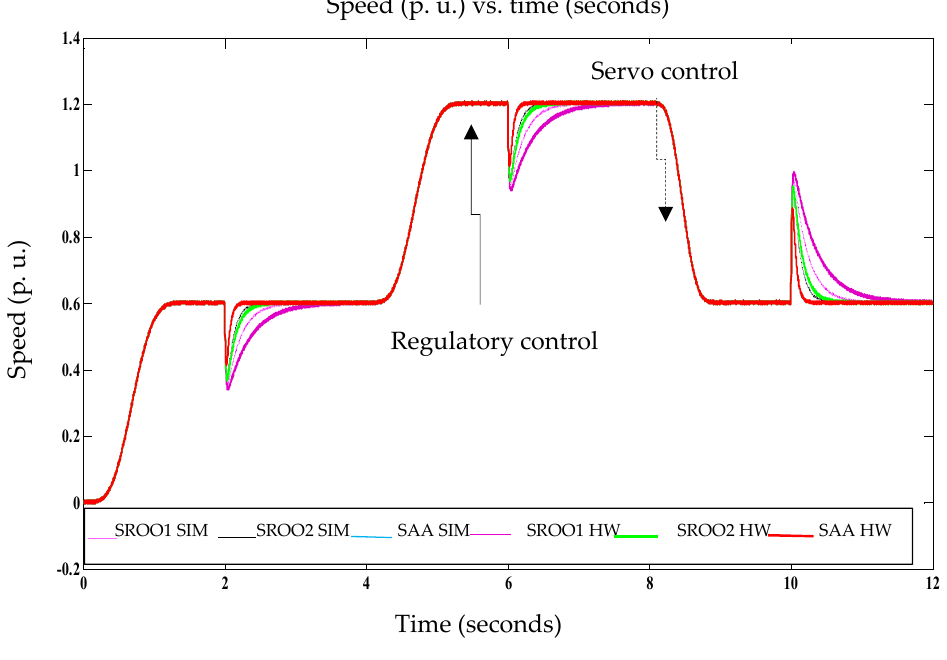
Electronics 2020 , 9 , x FOR PEER REVIEW Figure 10. Measured speed of the DC motor fed from the Luo converter. Figure 10. Measured speed of the DC motor fed from the Luo converter.